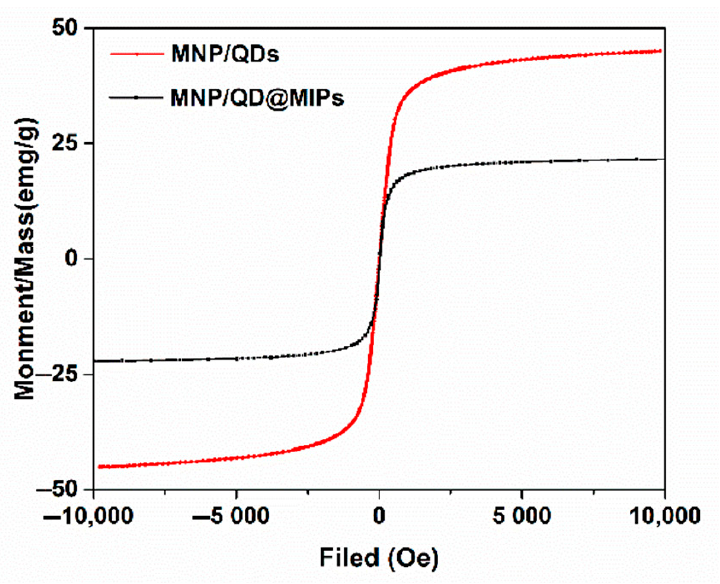
Figure 3. The magnetic hysteresis loops of MNP/QDs and MNP/QD@MIPs.